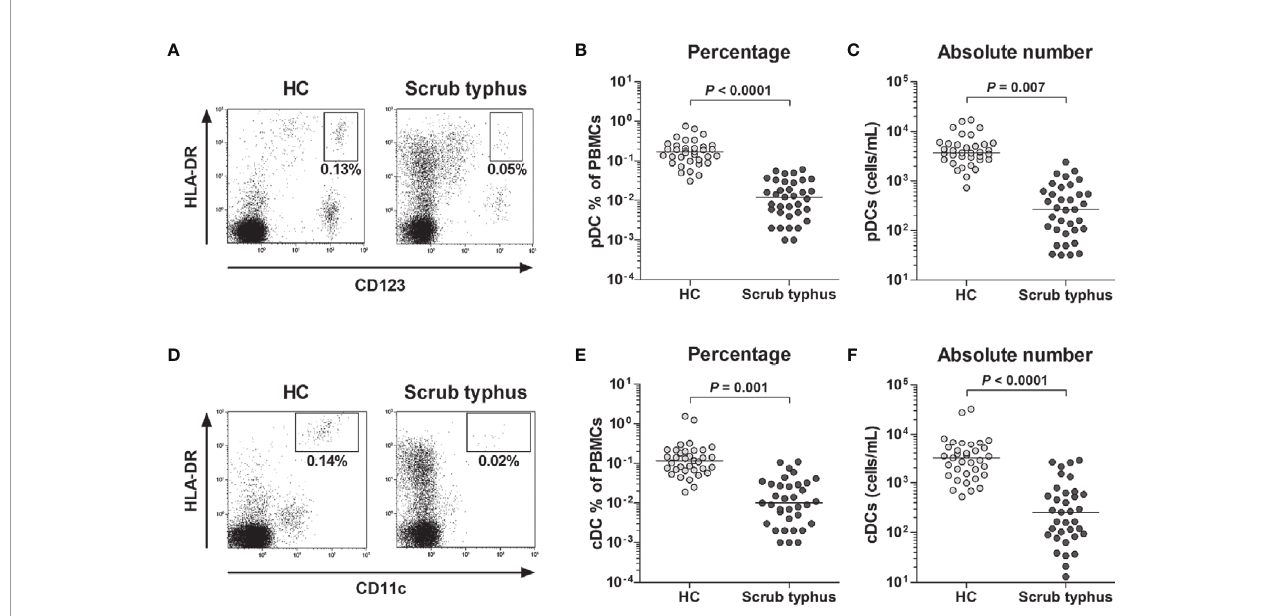
FIGURE 1 | Decreased numbers of circulating pDCs and cDCs in peripheral blood samples of scrub typhus patients. Freshly isolated PBMCs from 35 HCs and 35 scrub typhus patients were stained with APC-conjugated anti-CD11c, BV421-conjugated anti-HLA-DR, FITC-conjugated Lineage Cocktail 1, and PE-conjugated anti- CD123 mAbs and then analyzed by fl ow cytometry. The percentages of pDCs and cDCs were calculated using a large gate including lymphocytes and monocytes. (A, D) Representative percentages of pDCs and cDCs determined by fl ow cytometry. (B, E) Percentages of pDCs and cDCs in PBMCs. (C, F) Absolute numbers of pDCs and cDCs (per milliliter of blood). The symbols represent individual subjects and the horizontal lines are median values. P values were calculated by ANCOVA